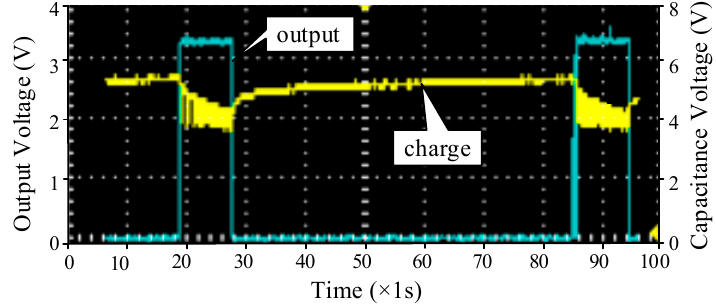
Figure 4. Adaptive working.